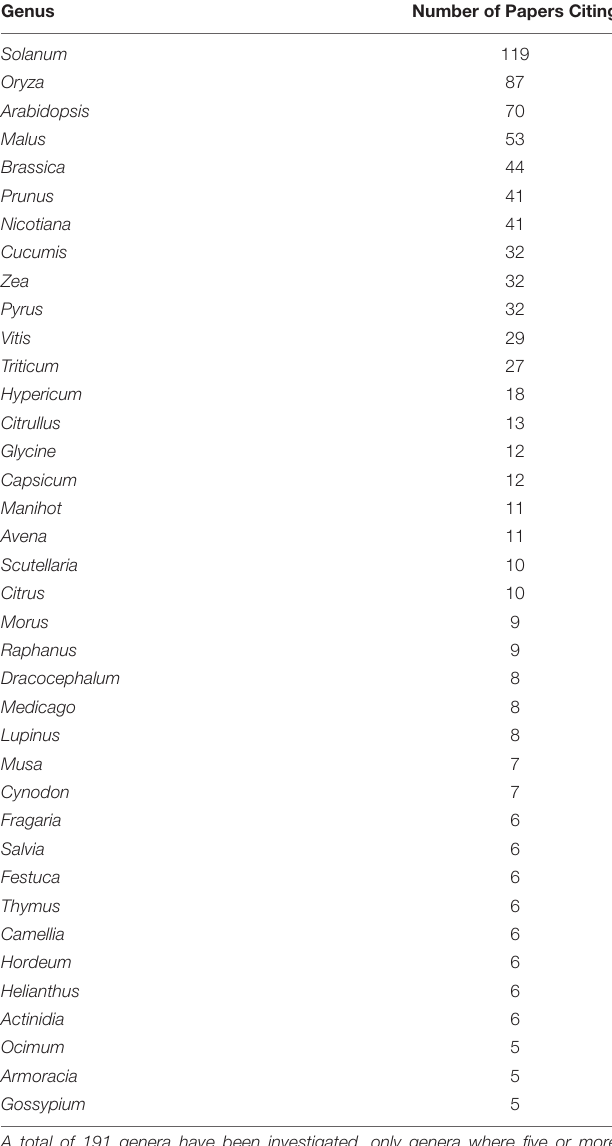
TABLE 1 | Summary of genera in which melatonin has been